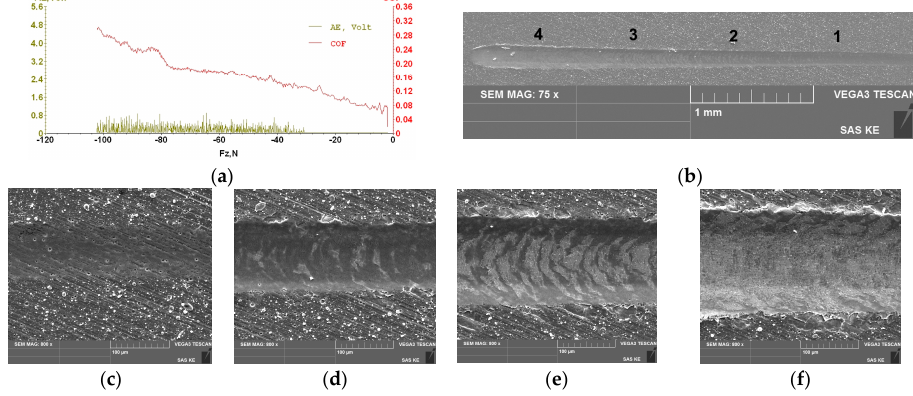
Figure 9. Acoustic emission of TiCN coating: ( a ) record AE-Fz, COF-Fz; ( b ) scratch–disposition and ( c – f ) detail of coating failure, position 1–4 respectively.